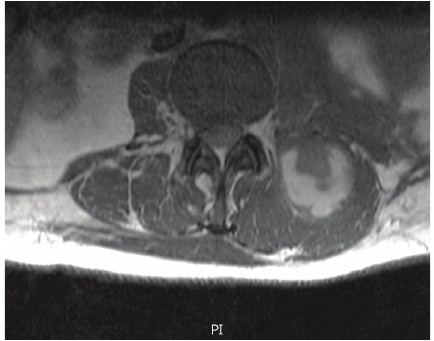
Figure 2: Axial section of MRI at the level of L5 showing left paraspinal intramuscular